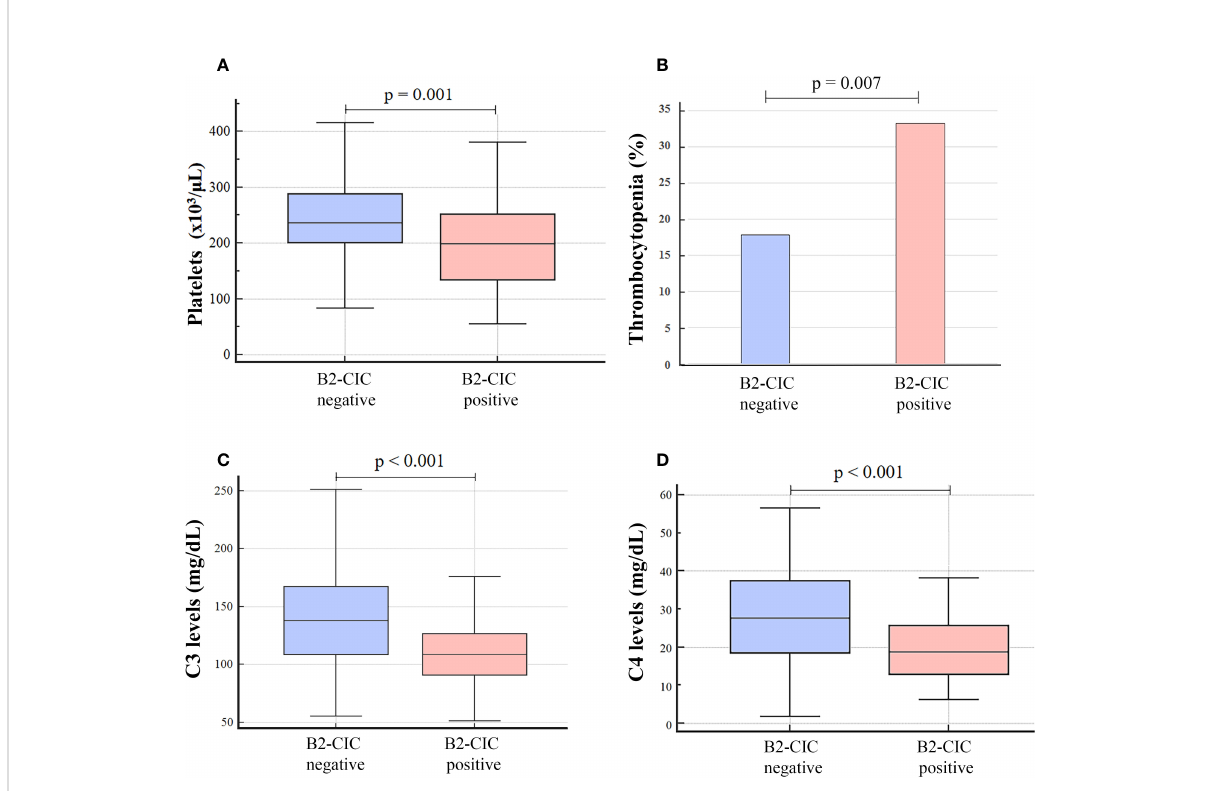
FIGURE 2 Platelet count ( A ), incidence of thrombocytopenia (B) and levels of C3 (C) and C4 (D) in patients with total thrombotic APS, positive and negative for B2-CIC